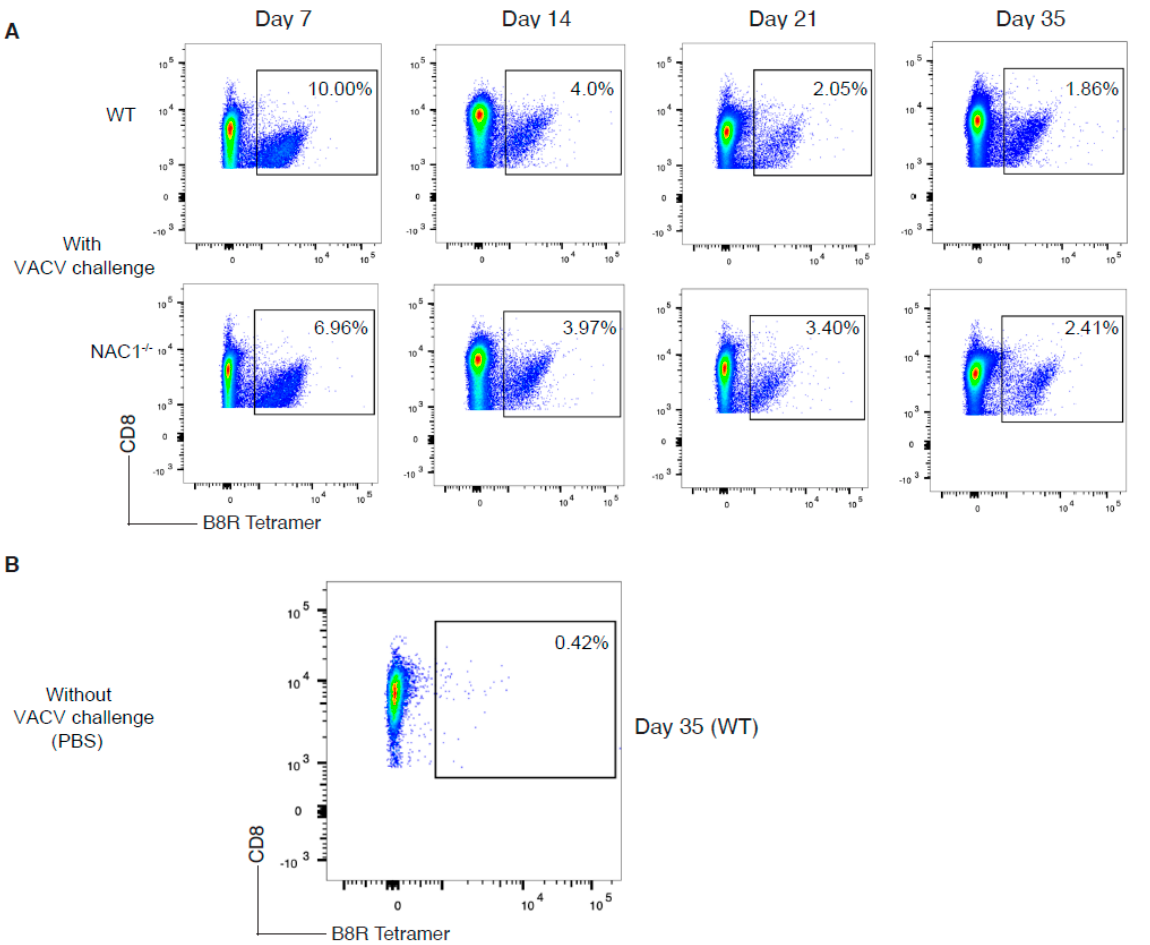
Figure 3. Comparison of development of viral Ag-specific CD8 + T cells. The VACV-specific CD8 + T cell frequency was monitored in WT or NAC1 − / − mice for 35 days after VACV challenge. ( A ) Mice were challenged with VACV at 2 × 10 6 PFU/mouse. The spleen and LNs (superficial cervical, axillary, brachial, and inguinal nodes) were dissected, smashed, and stained with CD8 Ab and B8R tetramer. On day 7, day 14, day 21, and day 35, Ag-specific cell frequencies were analyzed by flow cytometry. ( B ) VACV-uninfected mice were used as a control. The spleen and lymph nodes were also dissected, smashed, and stained with CD8 Ab and B8R tetramer. The plotting data shown are representative of three identical experiments ( n = 5).